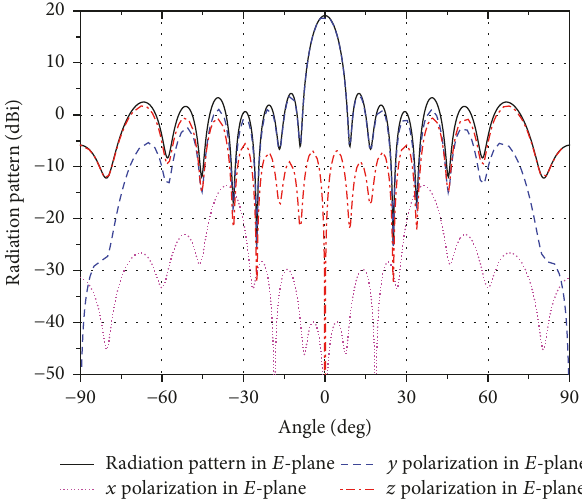
Figure 5: Simulated 𝐸 -plane radiation patterns at 35